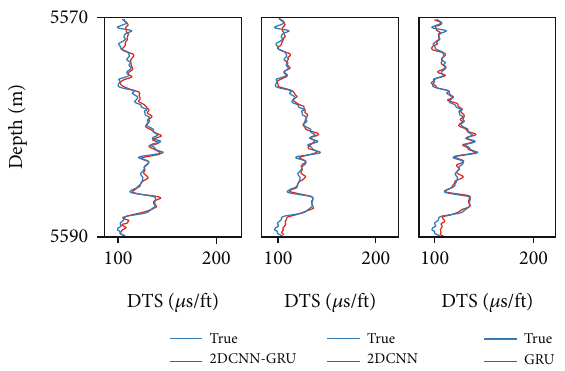
Figure 10: The local ampli fi cation comparison of 2DCNN-GRU, 2DCNN, and GRU.